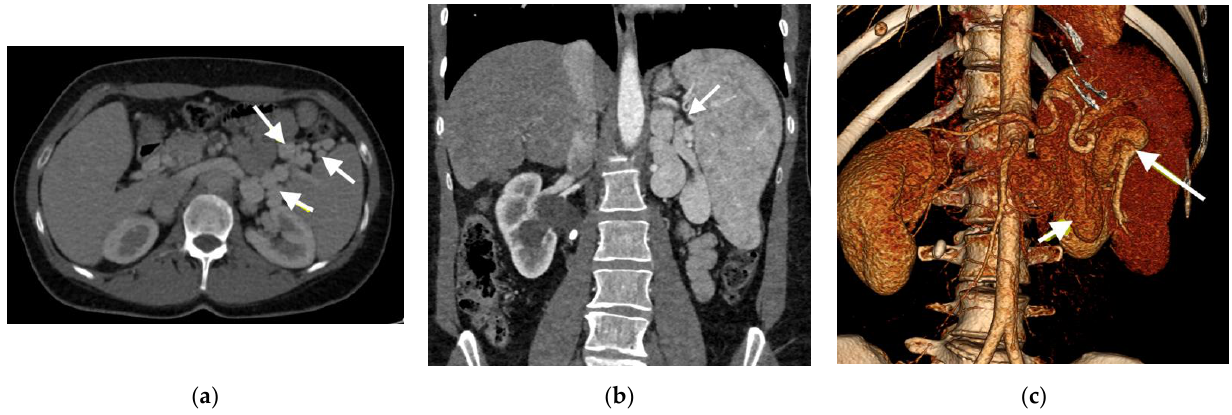
Figure 6. Computed tomography (Patient 2). Arrows show varicose dilatation of the splenic vein: ( a ) sagittal view; ( b ) coronal view; ( c ) 3D reconstruction.